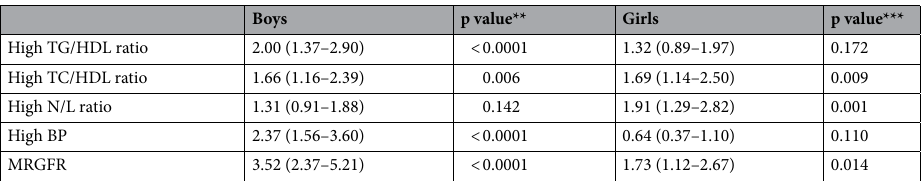
Table 4. Odds ratio (95%Cl) of cardiometabolic risk factors for 0.5 mg/dL of increased level in uric acid by gender. ** p value adjusted for centers, age, BMI-SDS, insulin dose/Kg/Die. *** p value adjusted for centers, age, insulin